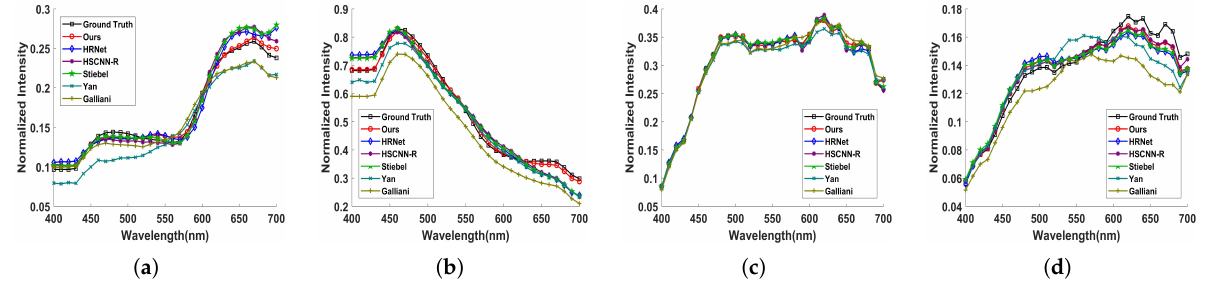
Figure 9. Spectral response curves of selected several spatial points from the reconstructed HSIs. ( a , b ) are for the NTIRE2020 “Clean” and “Real World” tracks respectively. ( c , d ) are for the NTIRE2018 “Clean” and “Real World” track